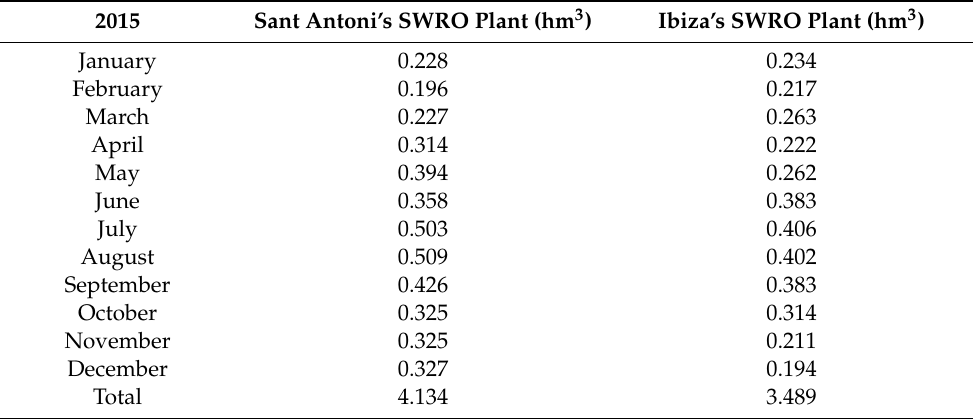
Table 5. Production of desalinated water on the island of Ibiza